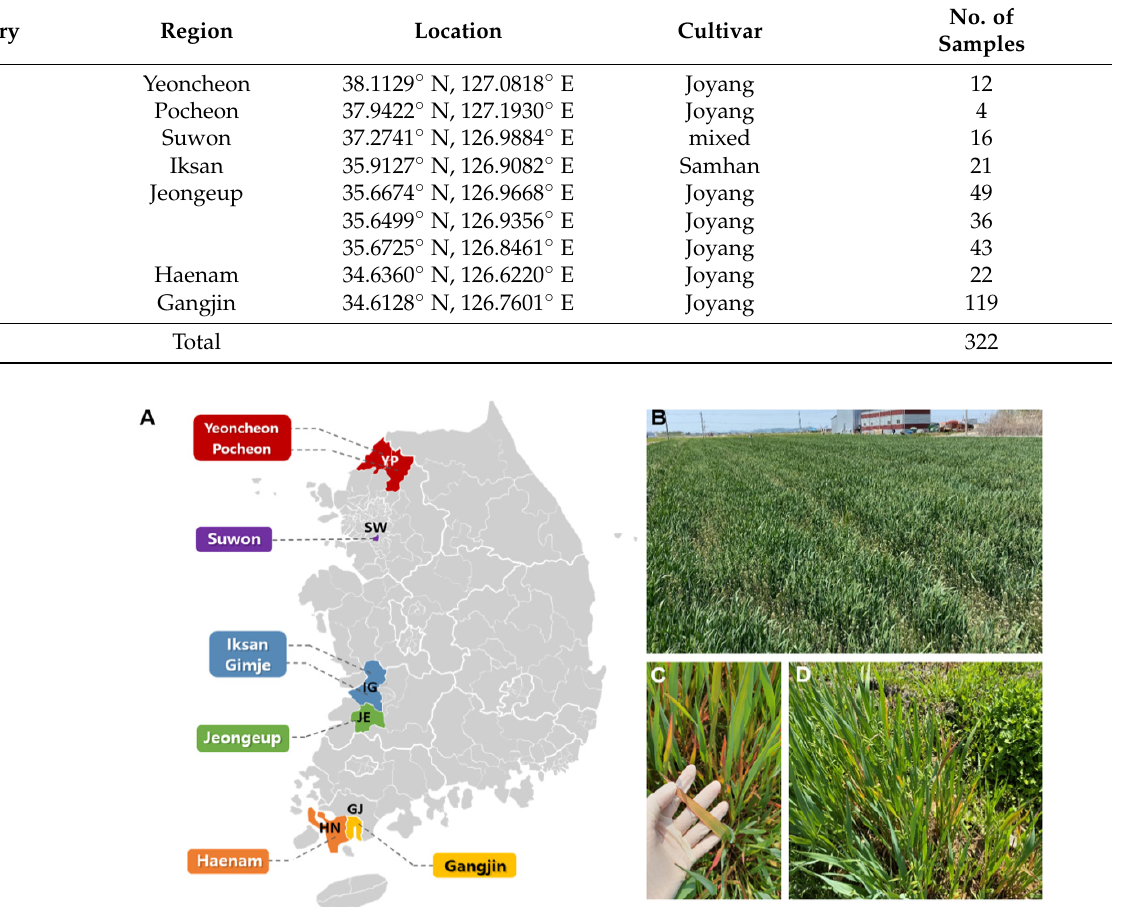
Figure 1. Locations of oats’ sample collection in Korea ( A ) and the viral symptoms of oat plants ( B – D ).